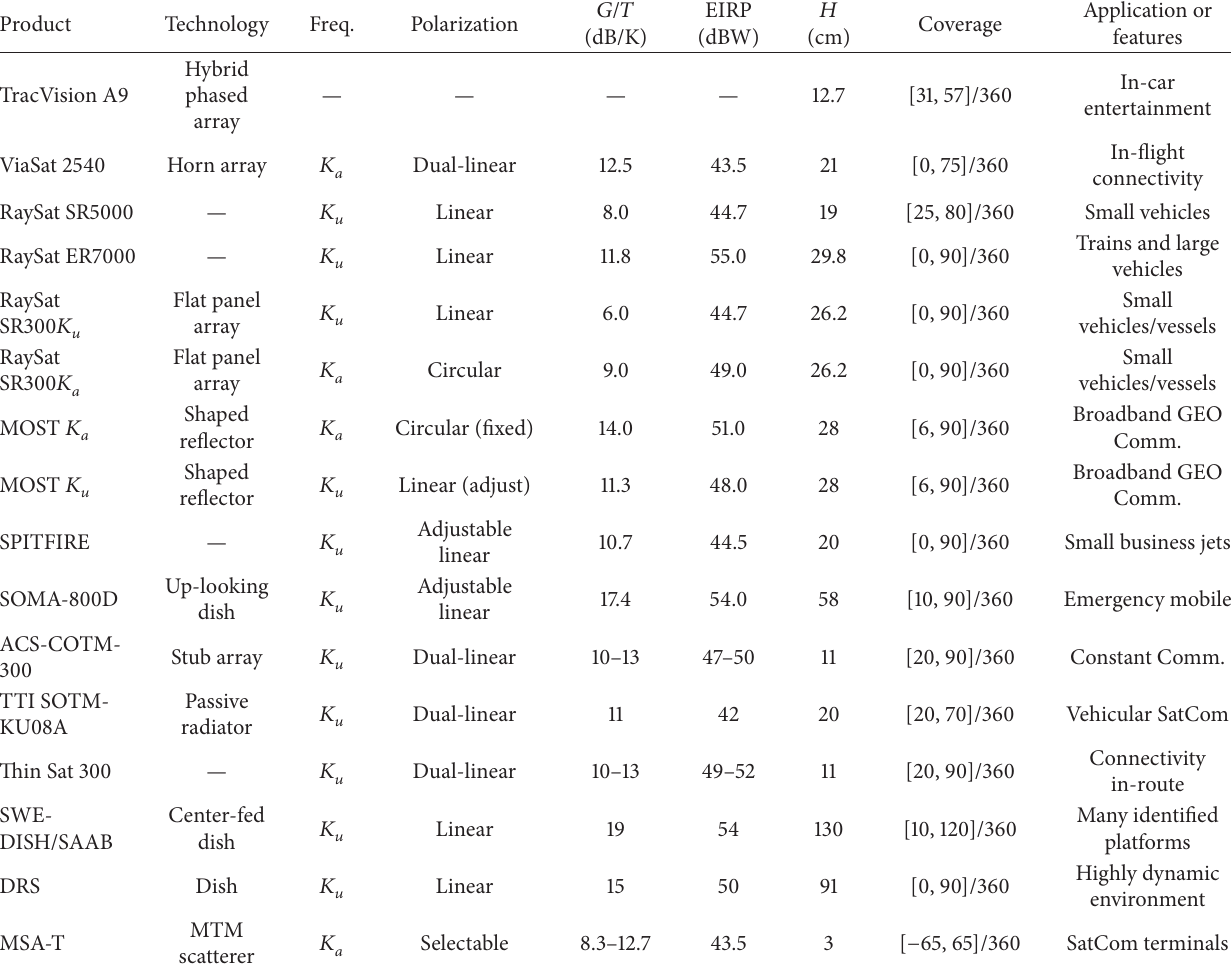
Table 1: The products of mobile antennas for satellite communication on the move in the